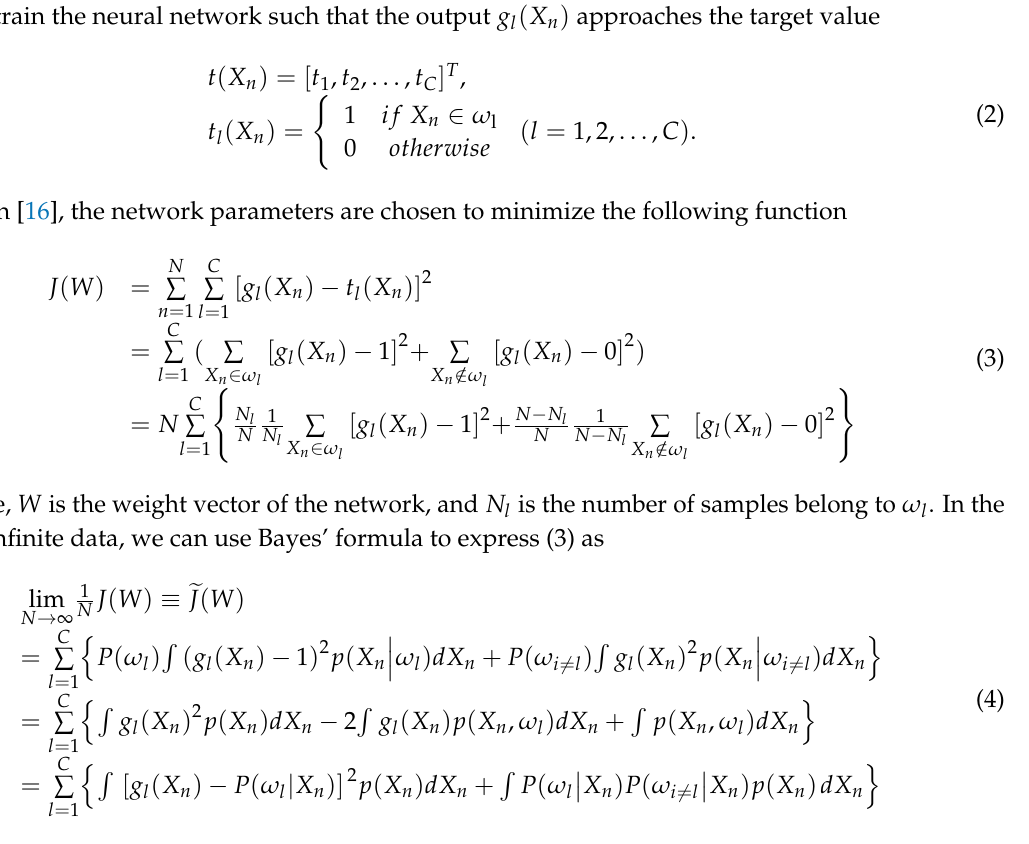
Figure 5. Multi-layer perceptron (MLP) model.